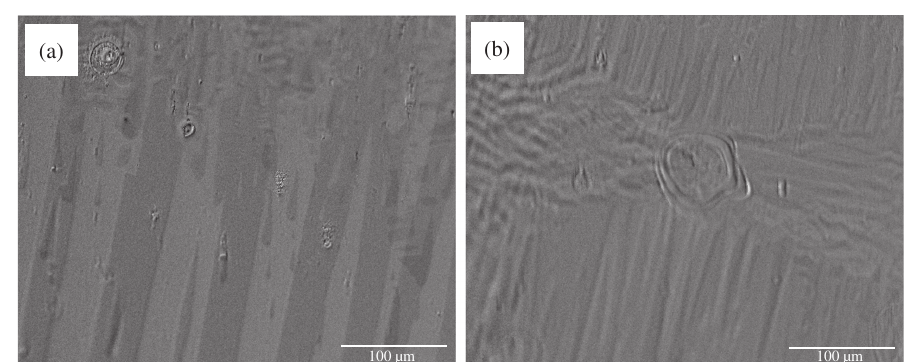
Figure 4: (a) Domains made visible by AFM without laser treatment (area 90 (cid:1) 90 µm) – magnetic domain sub-structure – lancet domains, (b) domains in the 0.6 mJ laser-treated silicon steel (area 50 (cid:1) 50 µm).